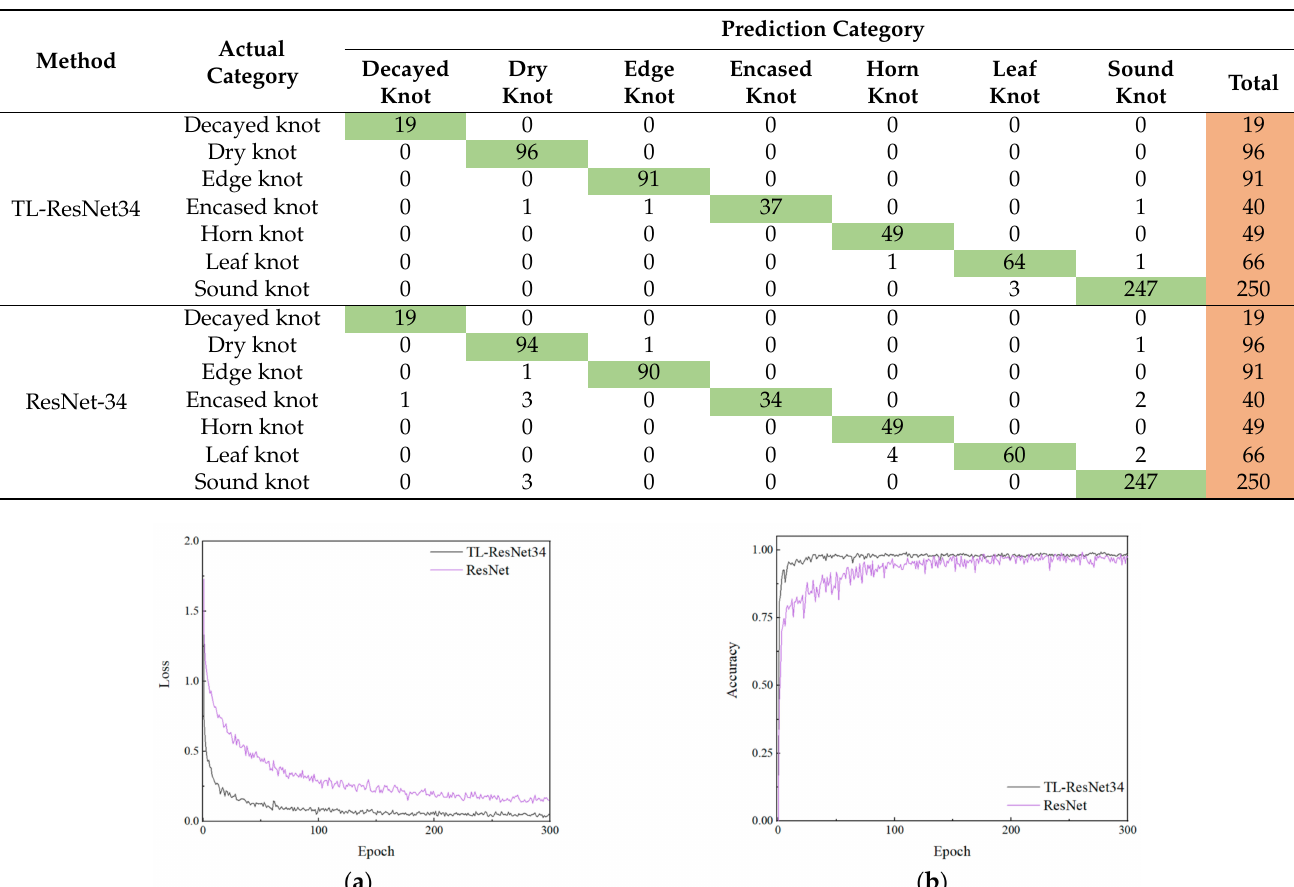
Table 6. Wood knots classification results of TL-ResNet34 and the contrast network. The green background color represents the number of correctly identified wood knot defects, and the orange back-ground color represents the total number of wood knot defects in each category.